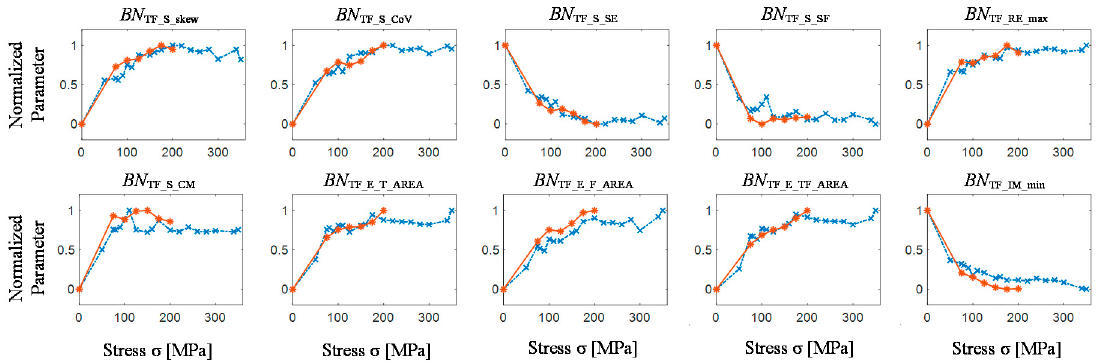
Figure 11. Distribution of selected features extracted from of TF representation of BN signal for successive stress-strain stages; sample s 1 results—red line; sample s 2 results—blue line.